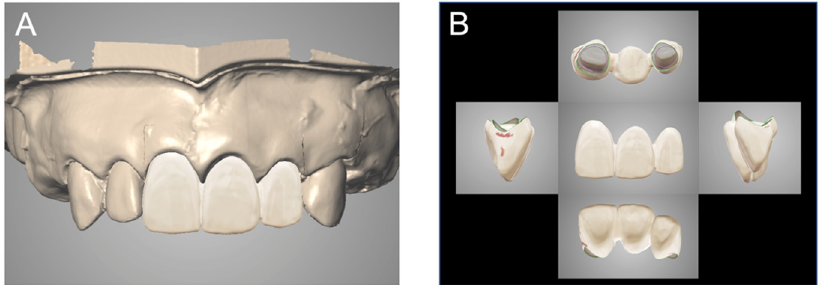
Figure 3. The digital wax-up of definitive restoration was completed by the conventional method. ( A ) Provisional restoration attached. ( B ) Provisional restoration.